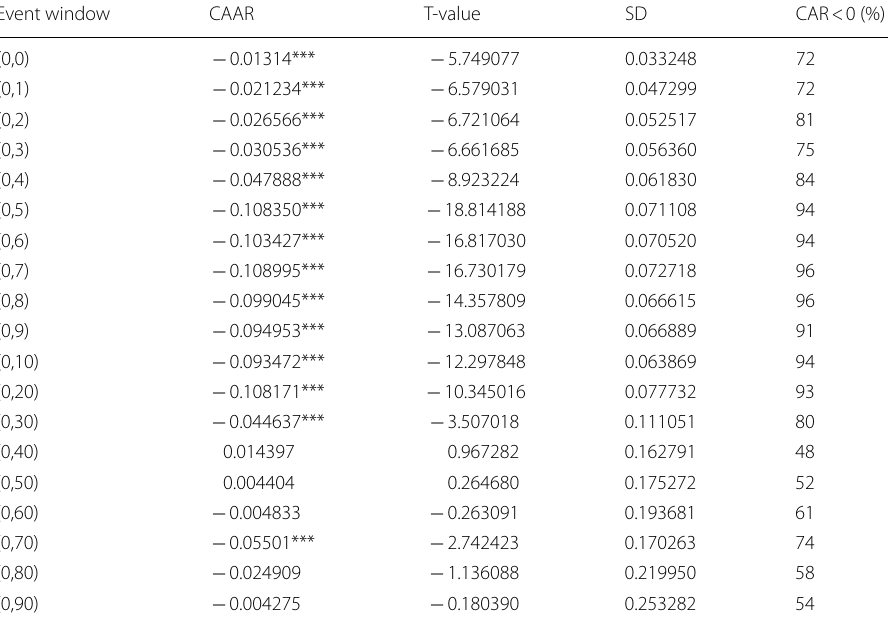
Table 3 The results of CAARs for different event windows